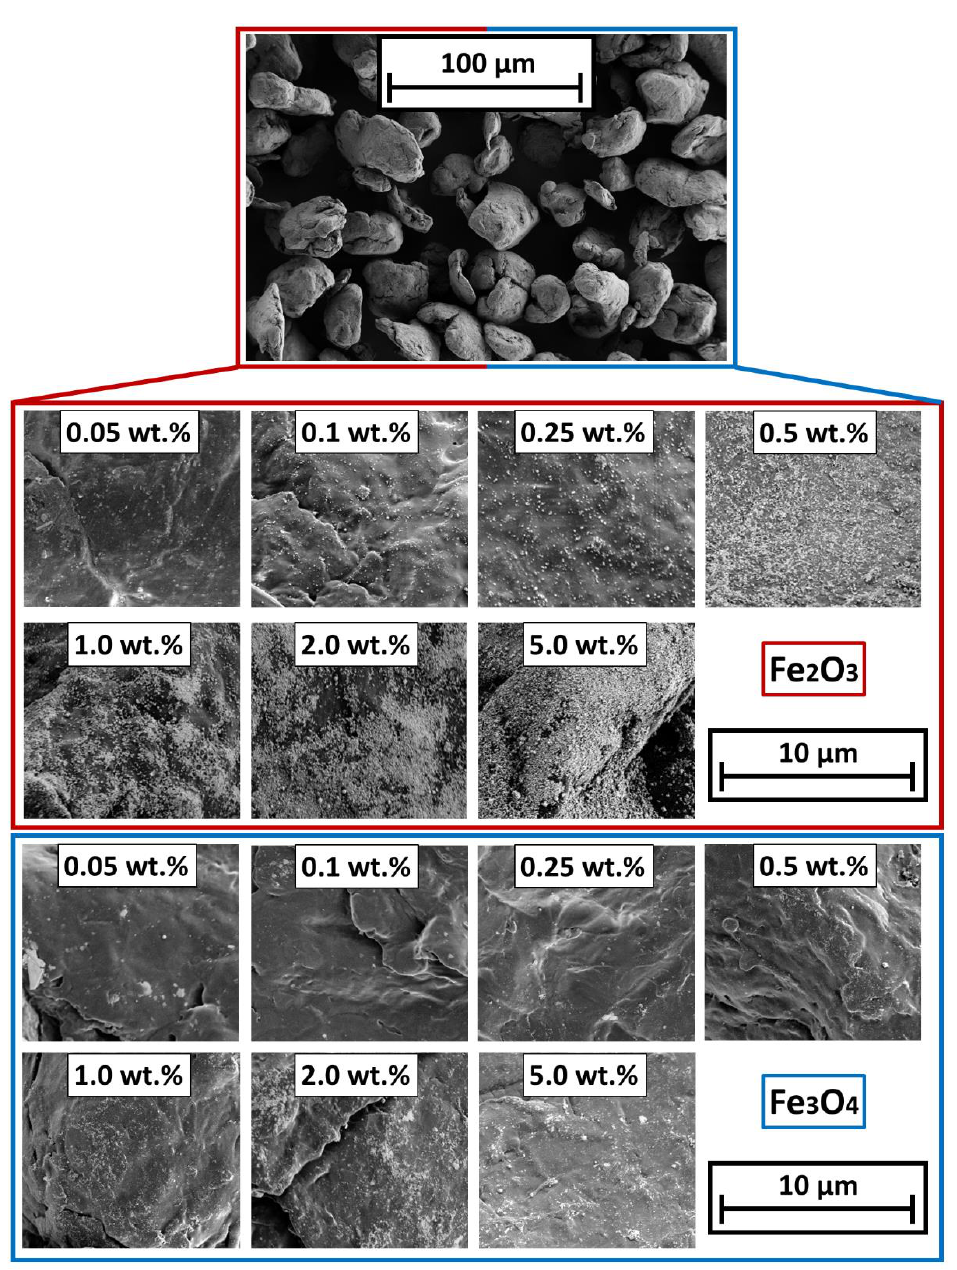
Figure 4. SEM micrographs of the different SPION coated polymer surfaces. ( Top ): Overview of the particle bulk; ( Bottom ): coated surfaces.